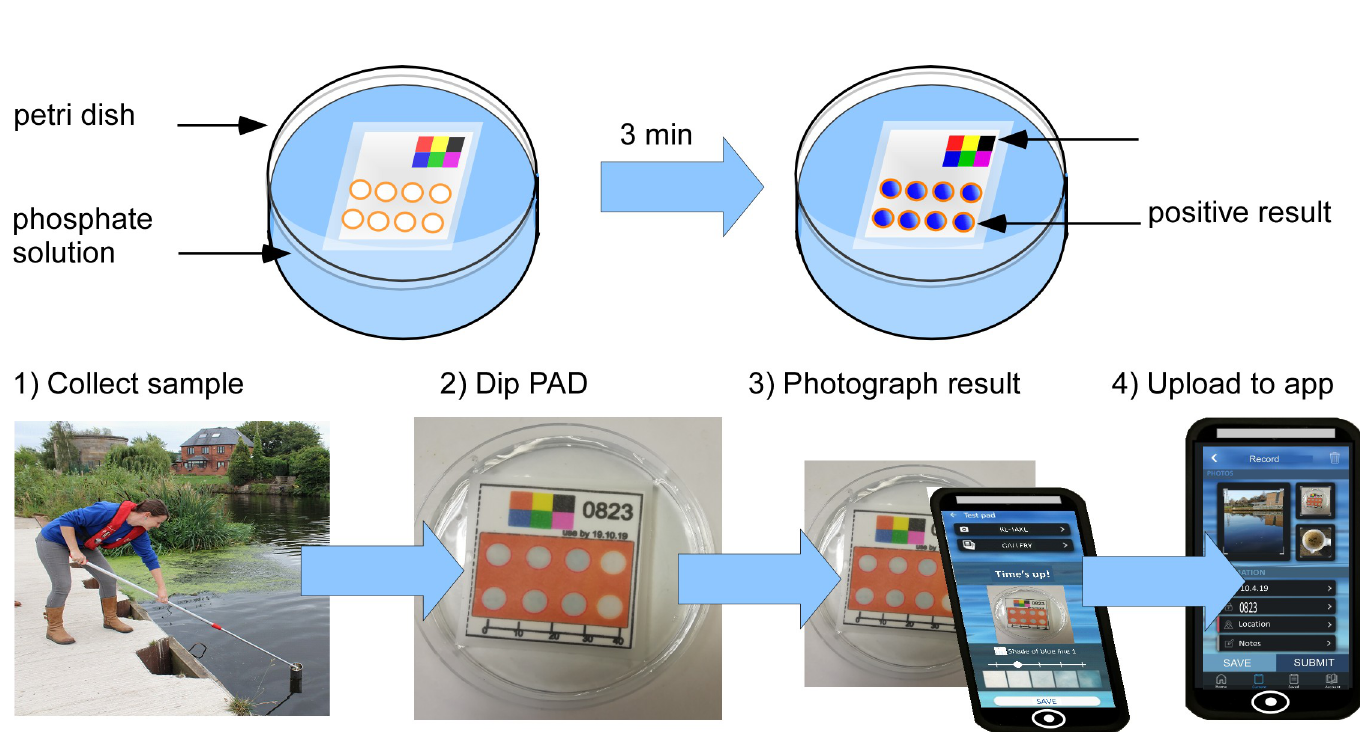
Fig 2. (a) The laboratory analysis workflow involved the paper device being placed into a dish with 20 mL aqueous sample. The sample entered through the slits in the back of the devices. After 3 min incubation, the formation of the blue colour on the upward facing side of the device was captured. (b) The workflow for volunteer sampling involved the collection of a water sample from a river and an aliquot being placed into a container. The paper device was dropped into the sample, the same as in the laboratory, and after 3 min, a photograph of the result was taken and uploaded via the RiverDip app.